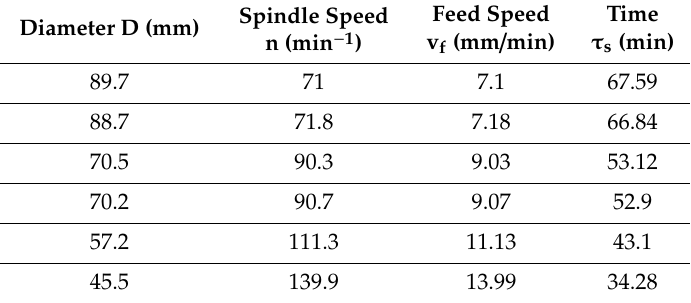
Table 5. Example of results—conventional lathe.